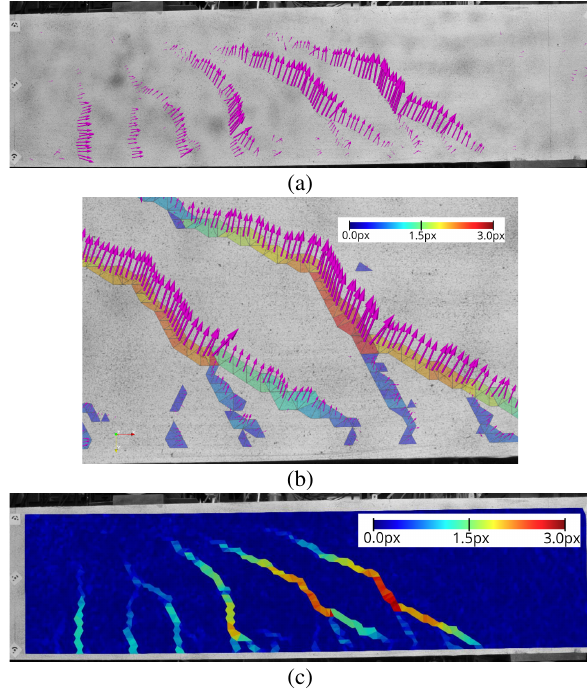
Figure 3. (a) Deformation vector field for the crack candidates (scale factor: 80); (b) zoom in for the deformation vector field (scale factor: 80); (c) color-coded triangular mesh of the scalar values of || ⃗t rel || , based on (Liebold and Maas, 2020).